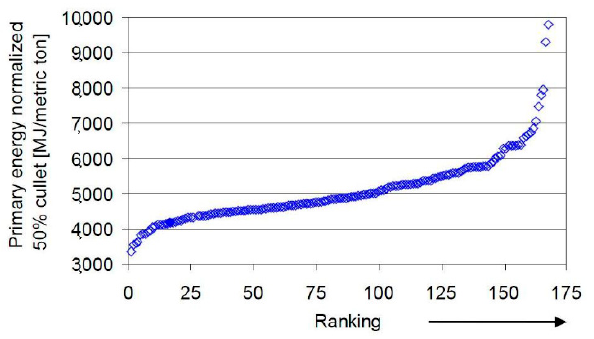
Figure 1. Example of ranking of energy efficiency from most efficient to lowest efficient container glass furnace of a set of 168 furnaces. Each point refers to one existing container glass furnace. Specific energy data are normalized to 50% cullet and the primary energy consumption takes electricity and oxygen production into account (adapted from Reference [6]).